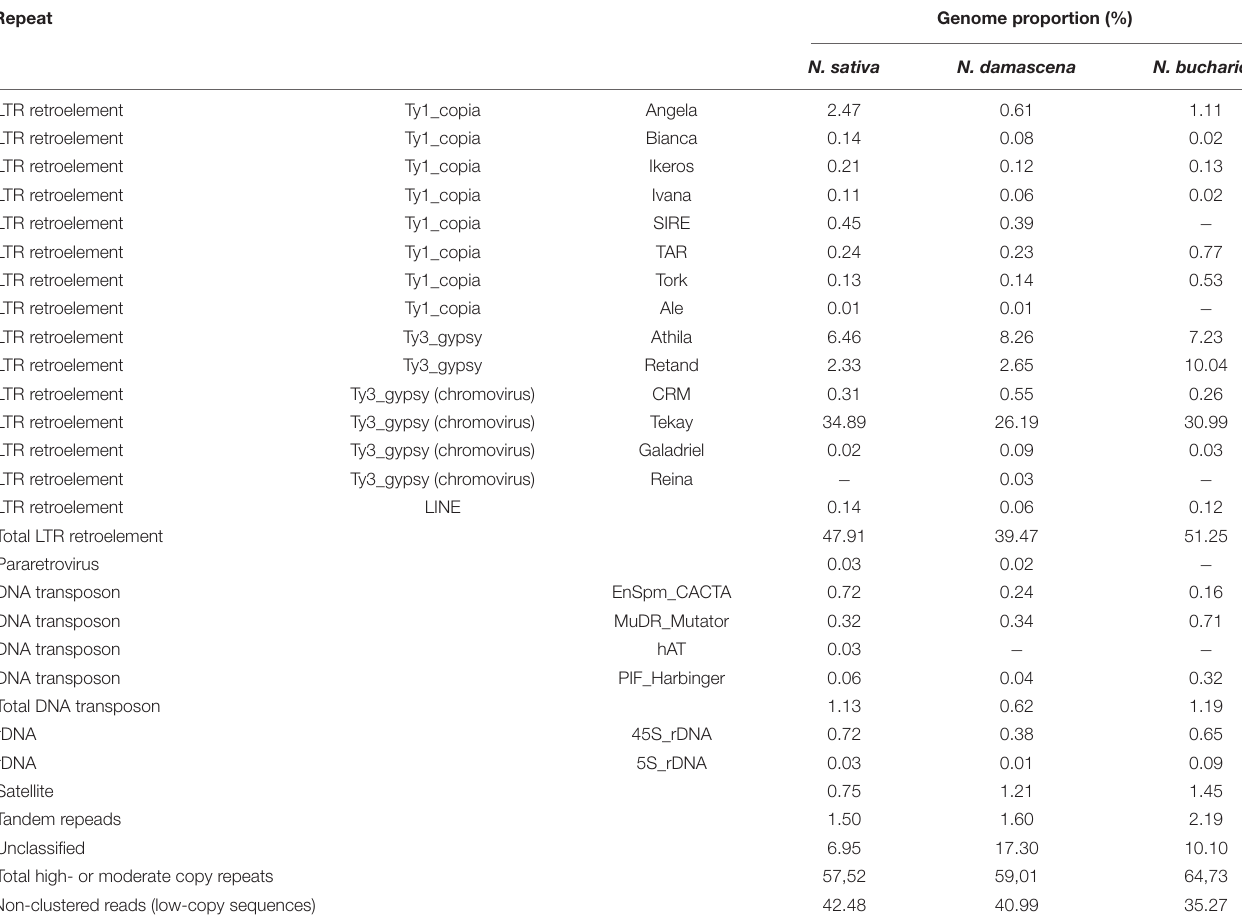
TABLE 2 | Types and proportions of highly-repetitive sequences in N. sativa , N. damascena and N. bucharica characterized by RepeatExplorer2. Repeat Genome proportion